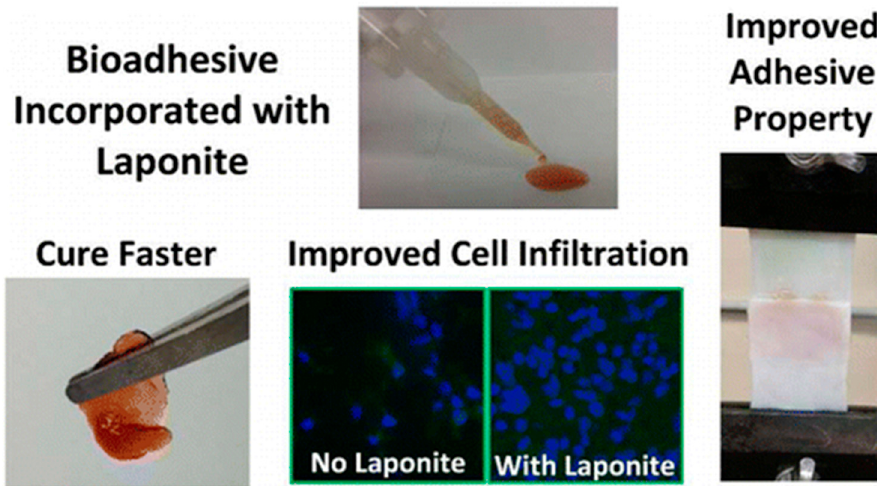
Figure 4. Injectable dopamine-modified poly(ethylene glycol) nanocomposite hydrogel with enhanced adhesive properties and bioactivity. Reprinted from Reference [82]. Copyright 2014 American Chemical Society.